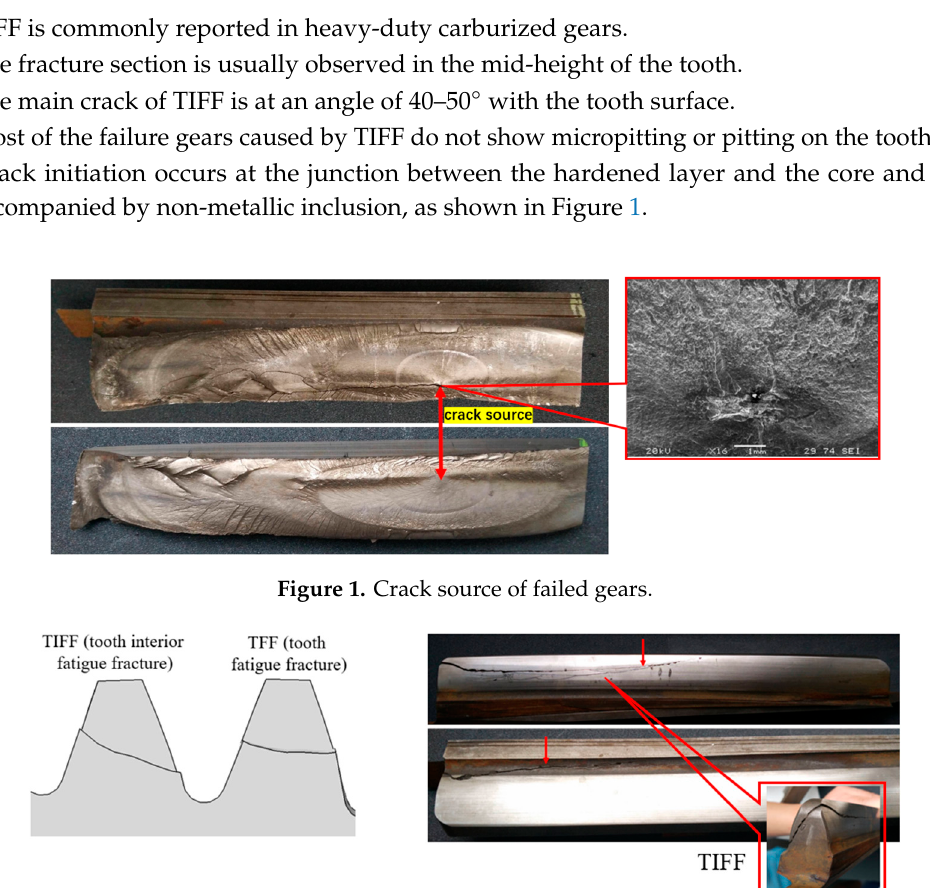
Figure 2. Tooth internal fracture fatigue Figure 1. Tooth internal fracture fatigue failure.